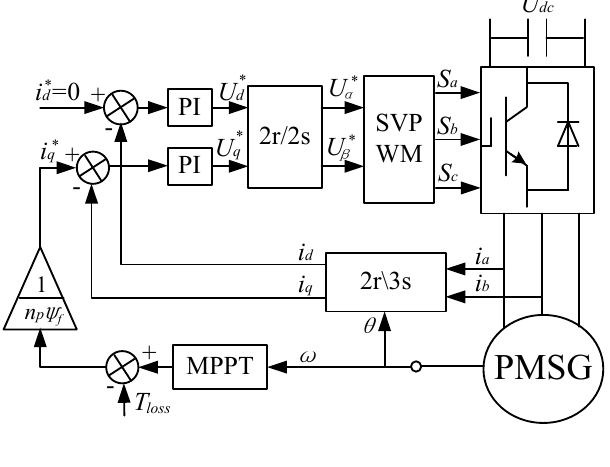
Figure 6. PMSG control configuration with the proposed OCG MPPT.